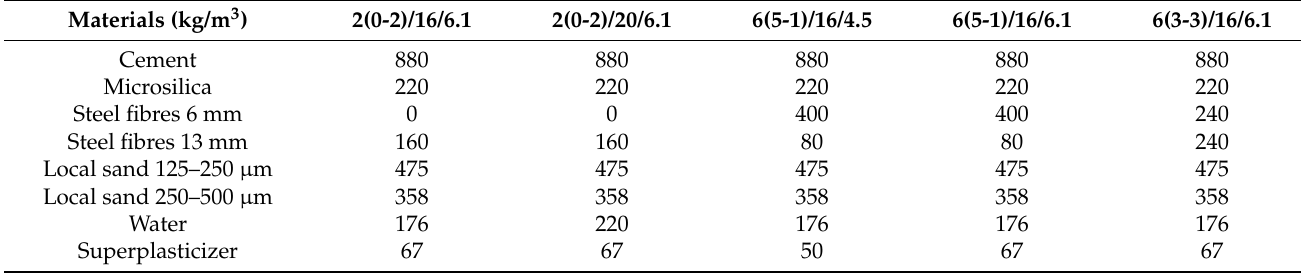
Table 2. Mixture designs for